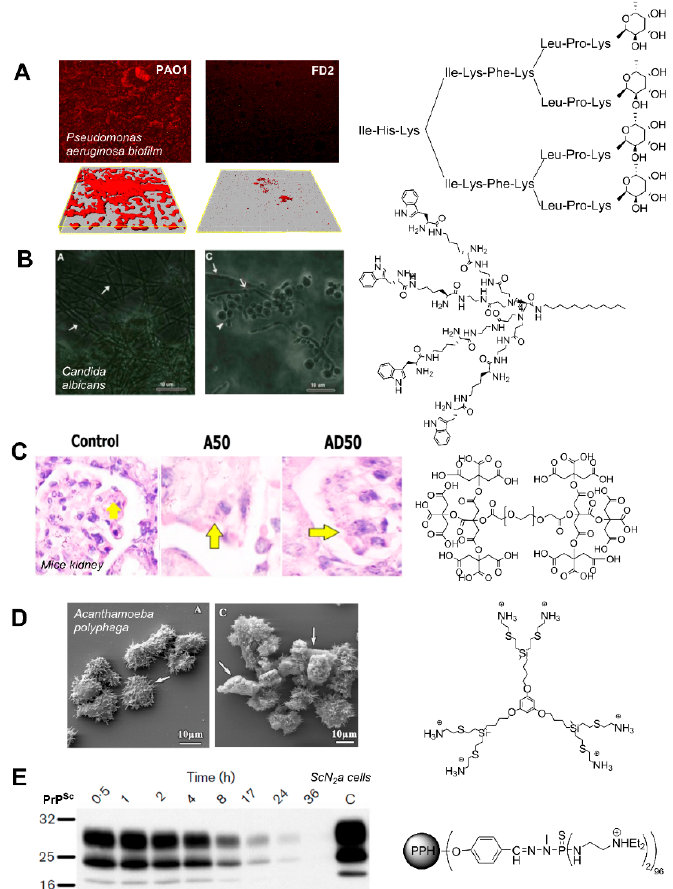
Figure 6. Examples of the antimicrobial activity of di ff erent dendritic molecules. ( A ) Inhibition of Pseudomonas aeruginosa biofilms by glycopeptide dendrimer FD2. Figure reprinted from ref. [100], Copyright 2008, with permission from Elsevier. ( B ) E ff ect on Candida albicans biofilm after treatment with a peptide dendrimer (16 µ g / mL). Figure reprinted from Ref. [102], Copyright 2015, with permission from Elsevier. ( C ) Decrease in the number of Leishmania Major parasites in mice kidney after treatment with a dendritic polyester (A50) and amphotericin B loaded dendrimer (AD50). Figure reprinted by permission from ref. [103], Springer Nature, Copyright 2018. ( D ) Alterations of Acanthamoeba polyphaga trophozoites after treatment with a carbosilane dendrimer (2 mg / L). Figure reprinted from ref. [104]. ( E ) Evolution of PrP Sc levels in ScN2a cells after treatment with a G4 PPH dendrimer (10 µ g / mL). Reprinted with permission from Ref. [105], SGM, Copyright